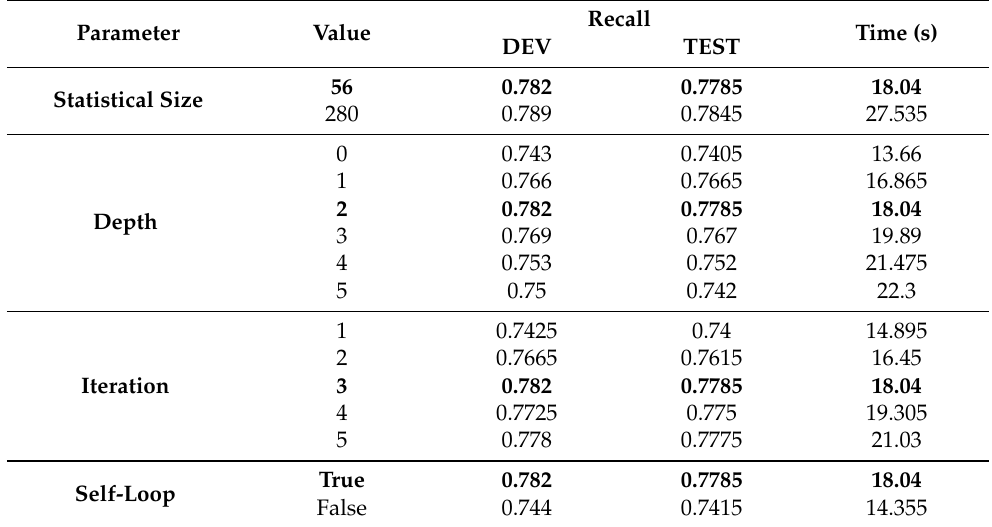
Table 7. Parameter